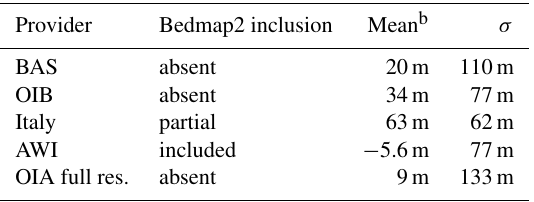
Table 3. Bed elevation data set comparison to Bedmap2 a , with mean offset and standard deviation σ of bed elevation